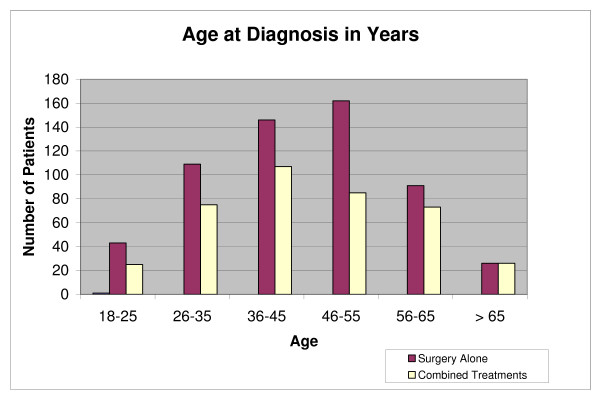
Age at Diagnosis in Years.